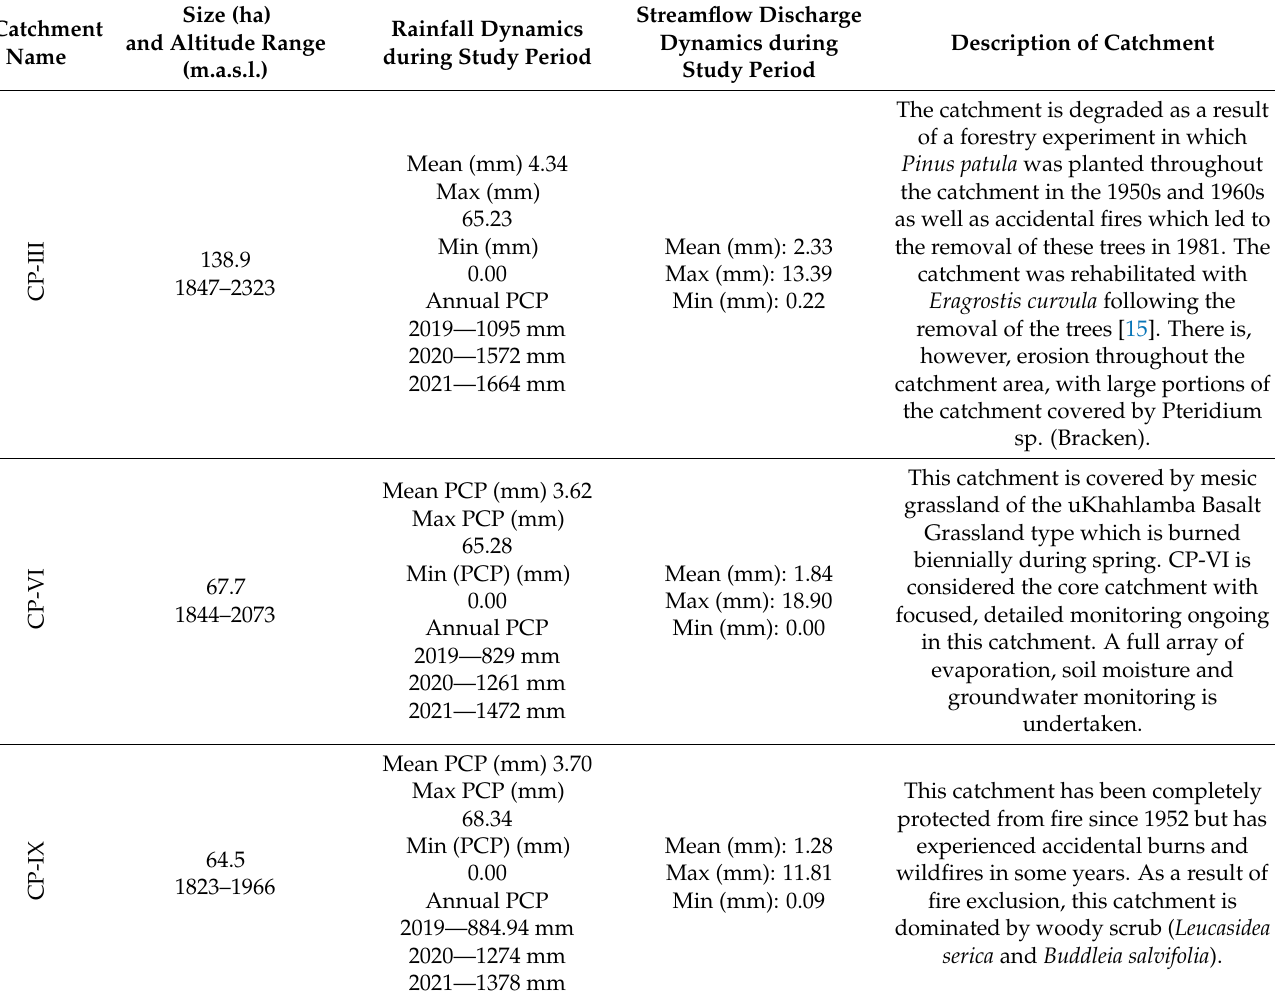
Table 1. General details of the three catchment areas during the study period (adapted from